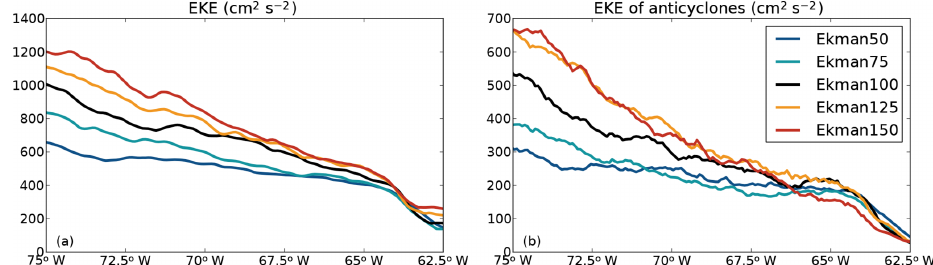
Figure 12. (a) Zonal variation of the maximum EKE between 12.5 and 17.5 ◦ N from 65 to 75 ◦ W for each simulation. (b) As (a) , but for the anticyclones with long tracks only. The EKE was averaged over the upper 50m. Note the difference in scale between the two